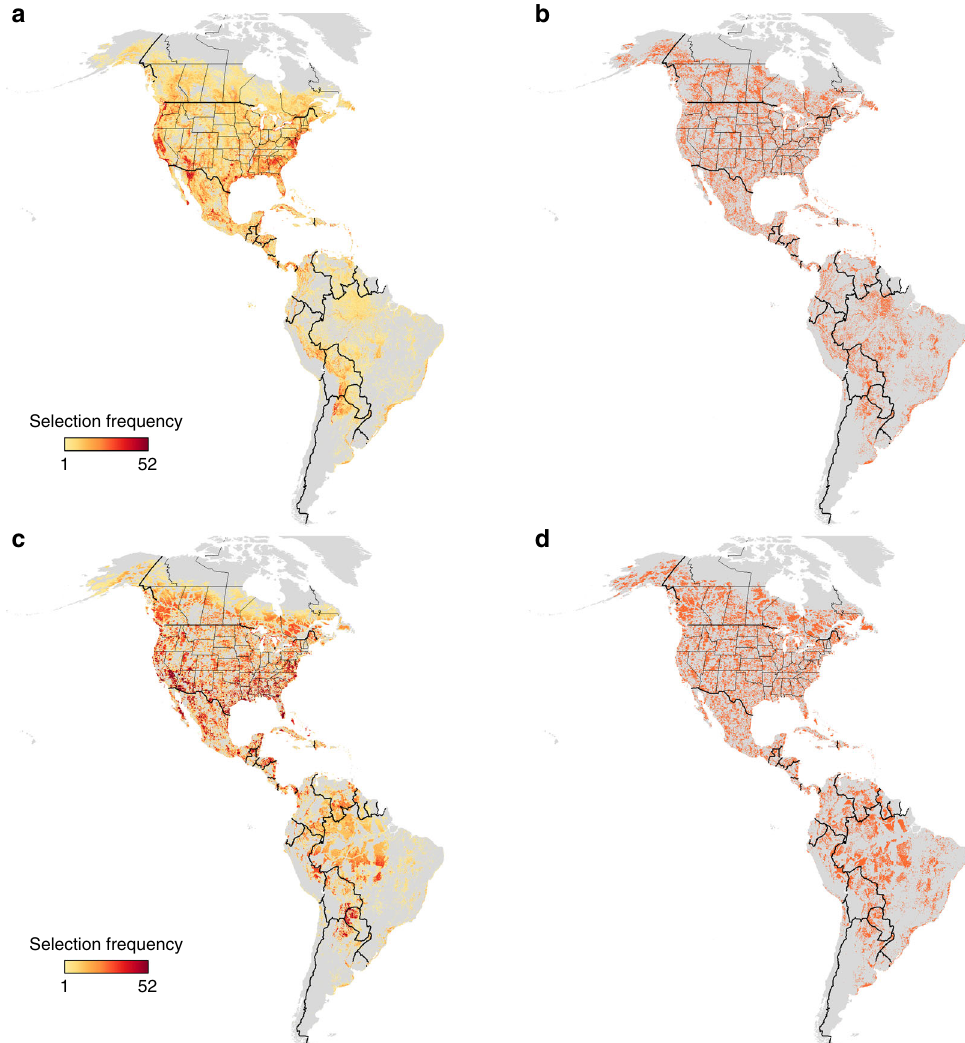
Fig. 2 Spatial clustering comparison results. Spatial clustering of species abundance comparison of areas prioritized for weekly and yearly planning under a shared-use approach allowing for the inclusion of human dominated landscapes vs. an intact habitat approach that excludes areas of high human footprint. The prioritization is based on a target of 30% of global populations of 117 species of Neotropical migratory birds when each species range is considered with spatial clustering of species abundance ( fi ve regional clusters). a = shared-use, weekly, b = shared-use, yearly, c = intact habitat, weekly, d = intact habitat, yearly. Panels a and c show how often (1, light yellow to 52, dark red) areas were selected across the weekly solutions. Panels b and d show whether an area was selected in a solution ( = red). Supplementary Fig. 3 presents a more detailed version of this fi gure focusing on northern